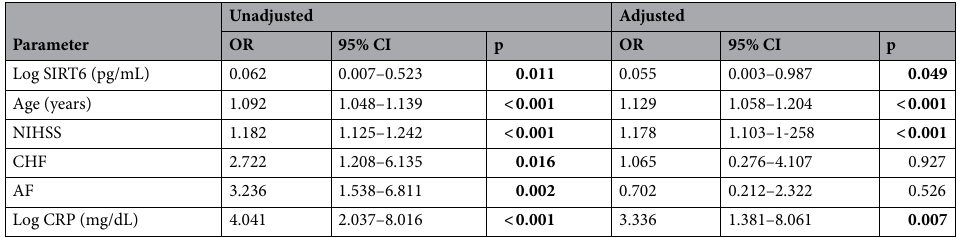
Table 2. Multivariate logistic regression for 90-day mortality. OR is calculated for unit increase of the independent variable (continuous variables) or for the presence of the factor (dichotomous variables). Significant p-values are highlighted in bold. AF: atrial fibrillation; CHF: chronic heart failure; CRP: C reactive protein; NIHSS: National Institute of Health Stroke Scale; SIRT6: sirtuin